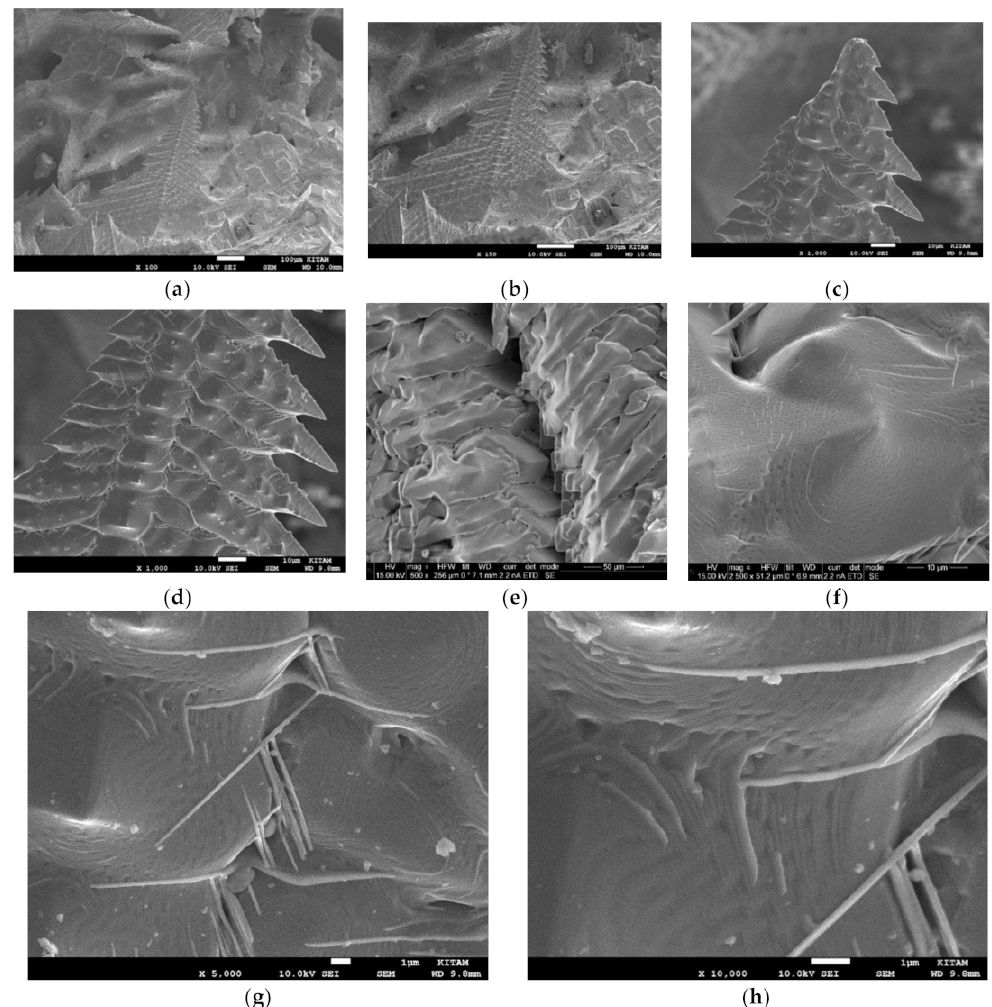
Figure 16. SEM images of the electrical tree formed when BaTiO 3 particles were microwave irradiated with plasma generation at 1800 W for 10 min. ( a , b ) General view of the electrical tree, scale bar = 100 µ m; ( c , d ) Detail of the electrical tree, scale bar = 10 µ m; ( e ) Fused structures on the electrical tree, scale bar = 50 µ m; ( f ) Surface structure of the electrical tree, Scale bar = 0 µ m; ( g , h ) Surface structure of the electrical tree showing the delamination of the layered structures and the formation of ca. 100 nm thick plates, scale bar = 1 µ